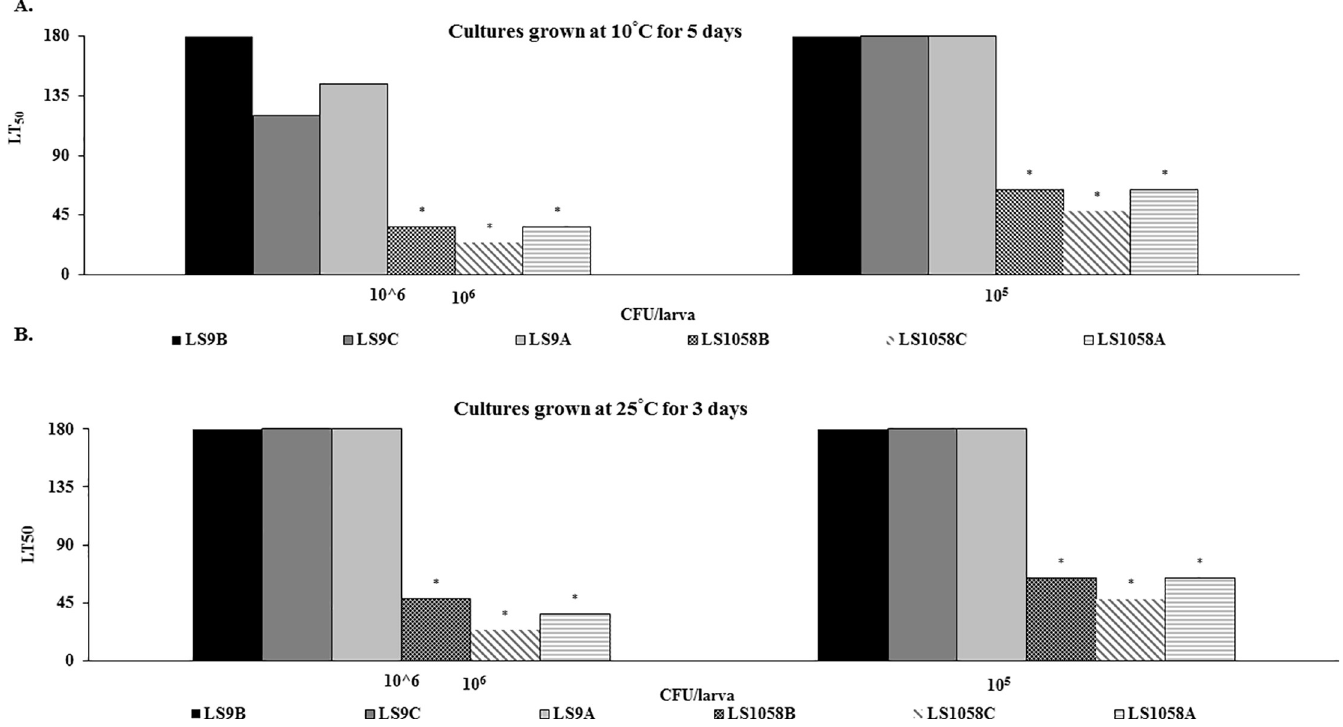
Fig 2. Lethal time necessary to kill half of larvae (LT50) inoculated with L . monocytogenes cells grown in either BHI ( ● ), cantaloupe ( & ) or apple fragments ( Δ ). An � indicates a significantly � (p < .0001) longer time needed to kill half of larvae inoculated with non-human pathogen L . innocua recovered from BHI (), cantaloupe ( & ) and apple ( Δ ) incubated at (A) 10˚C and (B) 25˚C, respectively. An � � indicates that we were not able to establish LT 50 values for L . innocua since number of dead larvae did not reach 50% over the monitoring period of seven